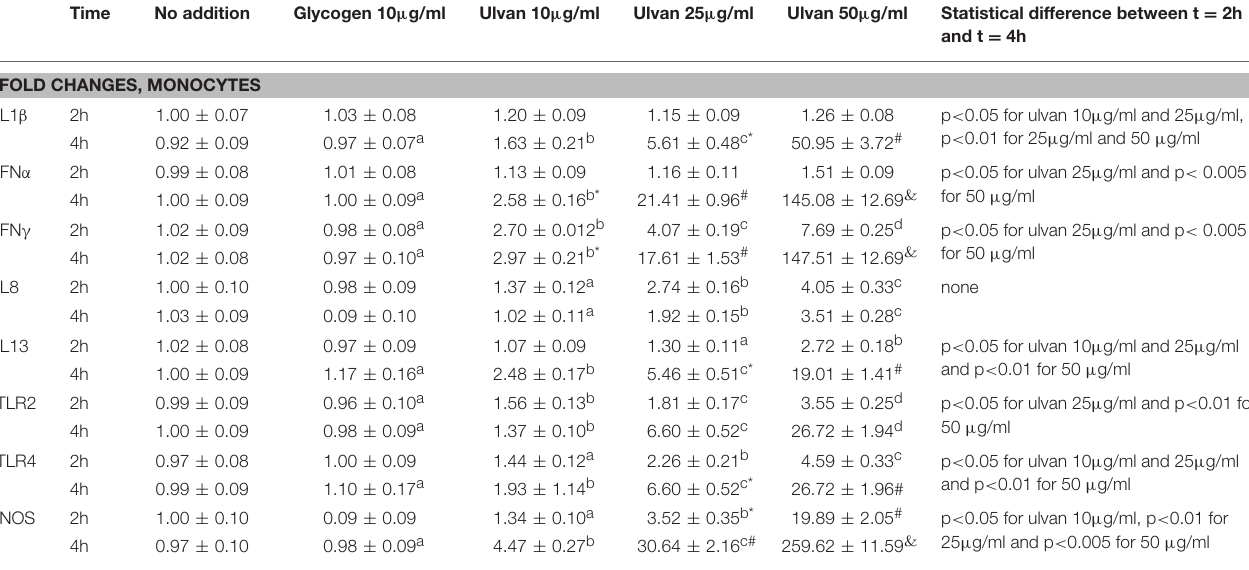
TABLE 6 | Ulvan triggers cytokine transcription in monocytes.